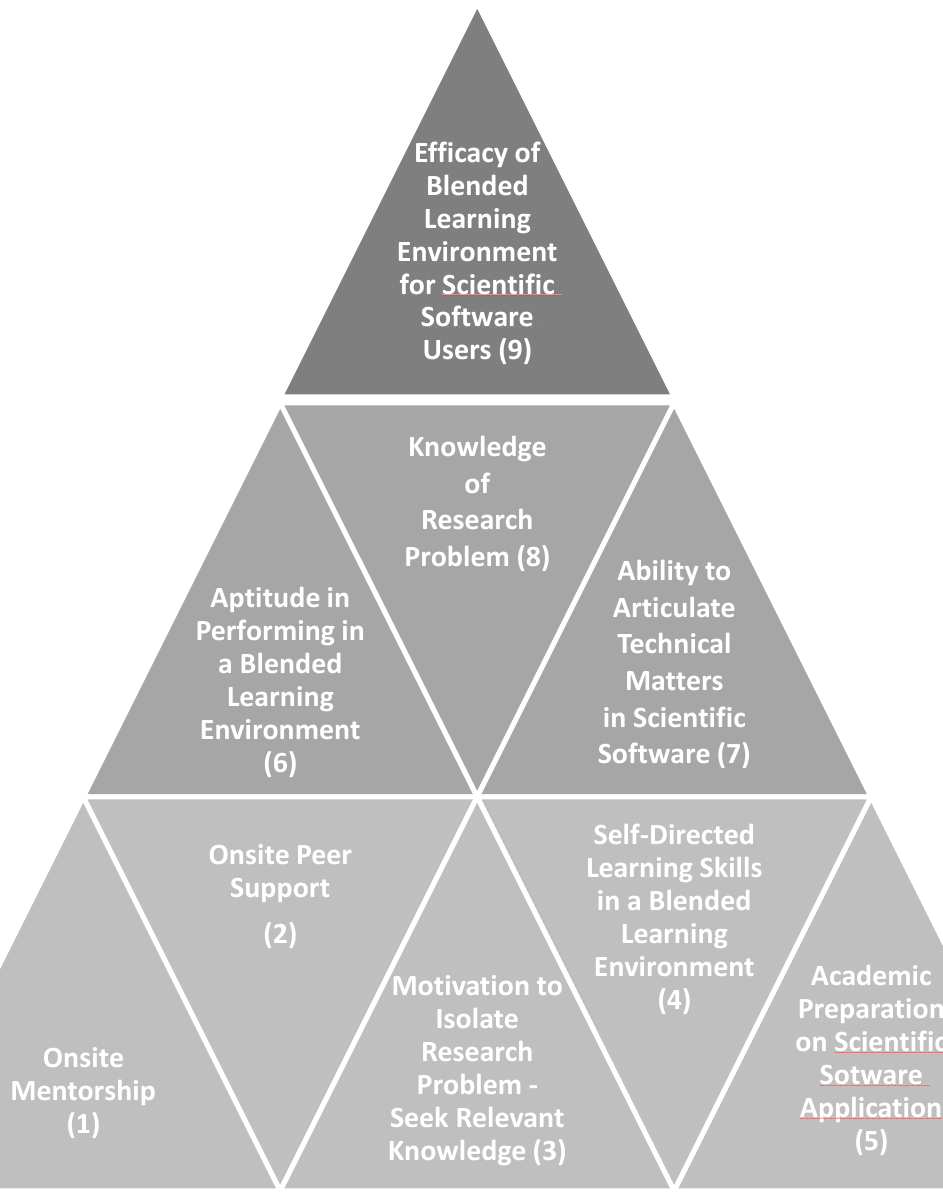
Figure 2. Parameters influencing the efficacy of blended learning in scientific software training. As indicated by the data analysis of this study, once the learners become familiar with the blended environment, the mode of knowledge delivery does not affect them anymore. At this stage, they have become able to concentrate on the quality of the transferred knowledge, and not on the profile of the online peer or their level of familiarity of technology or the degree of social presence in their online interactions. This can significantly enhance their ability to learn by focusing and critically analyzing the core of the information rather than its mode of